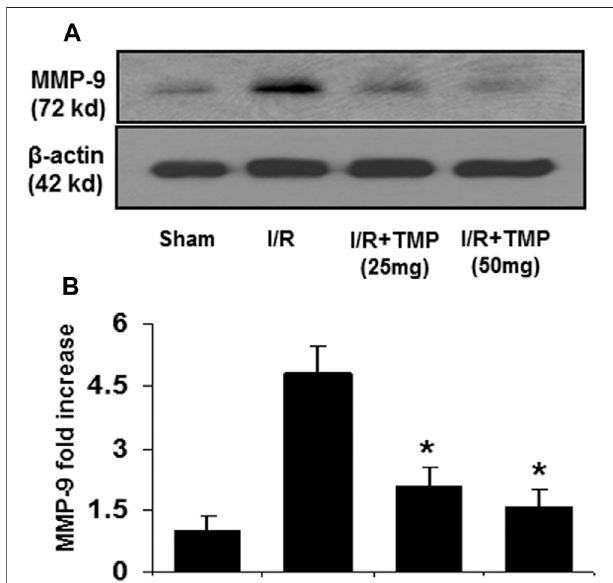
FIGURE 4 | TMP inhibits the expression of MMP-9 in the ischemic murinebrain.TheC57/BLmiceweretreatedwithTMP25 mg/kgor50 mg/kg or vehicle administered intraperitoneally 12 h before and after 2 h of MCAO, followed by 24 h reperfusion. Proteins extracted from the ischemic brains were subjected to immunoblot analysis with an antibody againstMMP- 9. (A) Representative photomicrographs show MMP-9 immunoreactivity in the ischemic brains in the different treatment groups. (B) The bar graphs representedthequanti fi cationofMMP-9expressionbydensitometricanalysis of the immunoreactive bands normalized to β -actin, and expressed as fold changes over the sham-operated controls. * p < 0.05 versus the I/R group. n (cid:1) 6 per group.